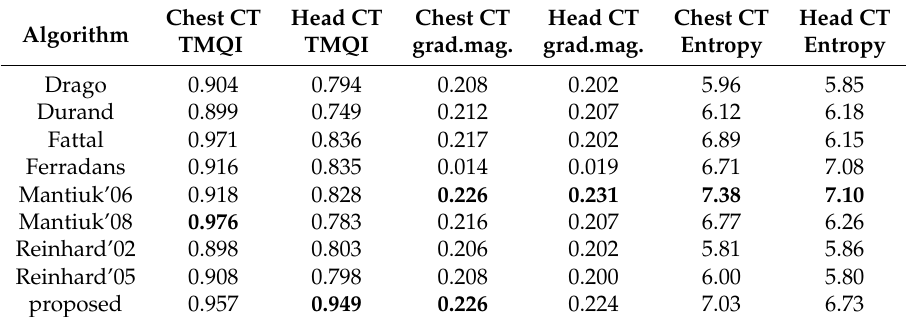
Table 1. Structural similarity scores from the TMQI algorithm, gradient magnitudes and image entropies. Bold text indicates the highest score.